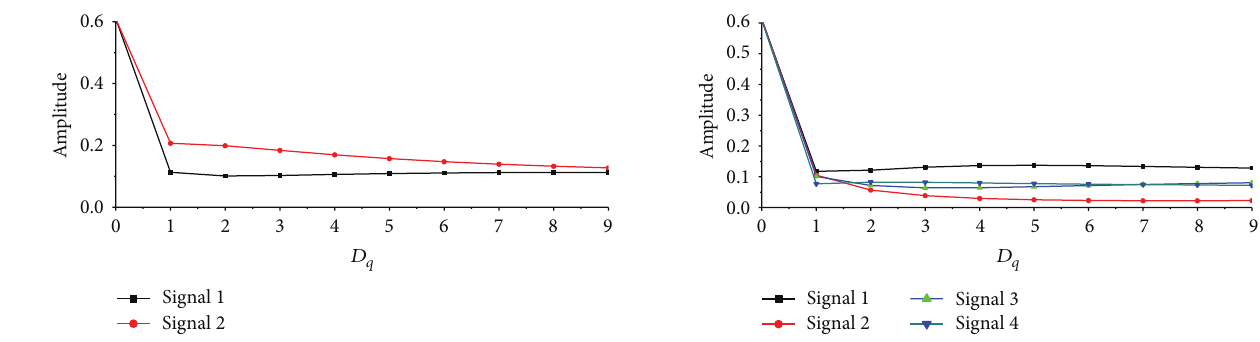
Figure 4: The generalized dimension curve of two simulation signals.